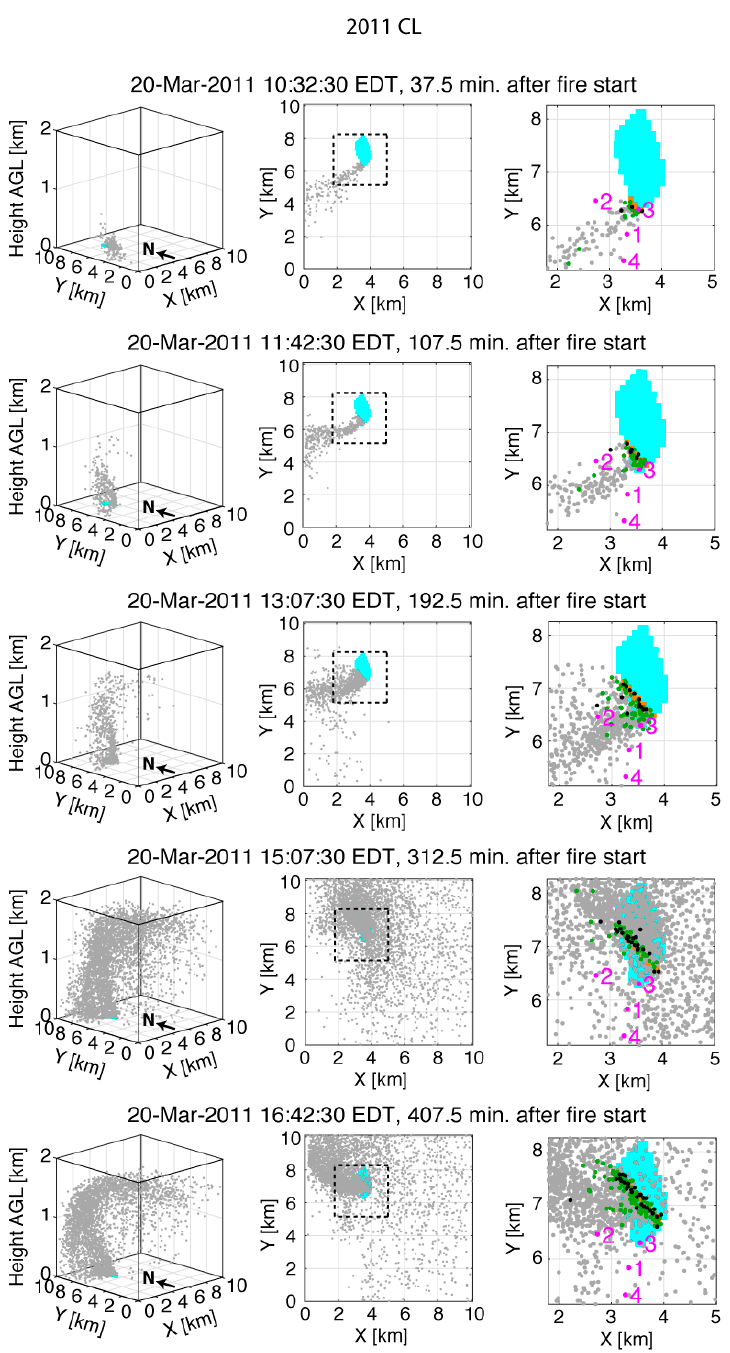
Figure 2. Visualization of the smoke plume in the 2011 control simulation (2011CL), from viewing positions southwest of plume looking northeast (left panels), and above the plume looking down (center panels). Right panels have the same orientation as the center panels but are zoomed in to the inset region indicated in the center panels by a dashed line. Particle elevation AGL is indicated by marker color (gray: Z > 18 m AGL; green: 2 m AGL < Z ≤ 18 m AGL; black: Z ≤ 2 m AGL). The ARPS-CANOPY burn unit is indicated with teal shading and the fire position with orange shading. Location of Dataram monitors is indicated with circles and corresponding numbers. Times displayed approximately correspond to peaks in the observed and/or simulated concentration time series at the Dataram locations. Note that particles displayed are a random selection of 25% of all particles in the